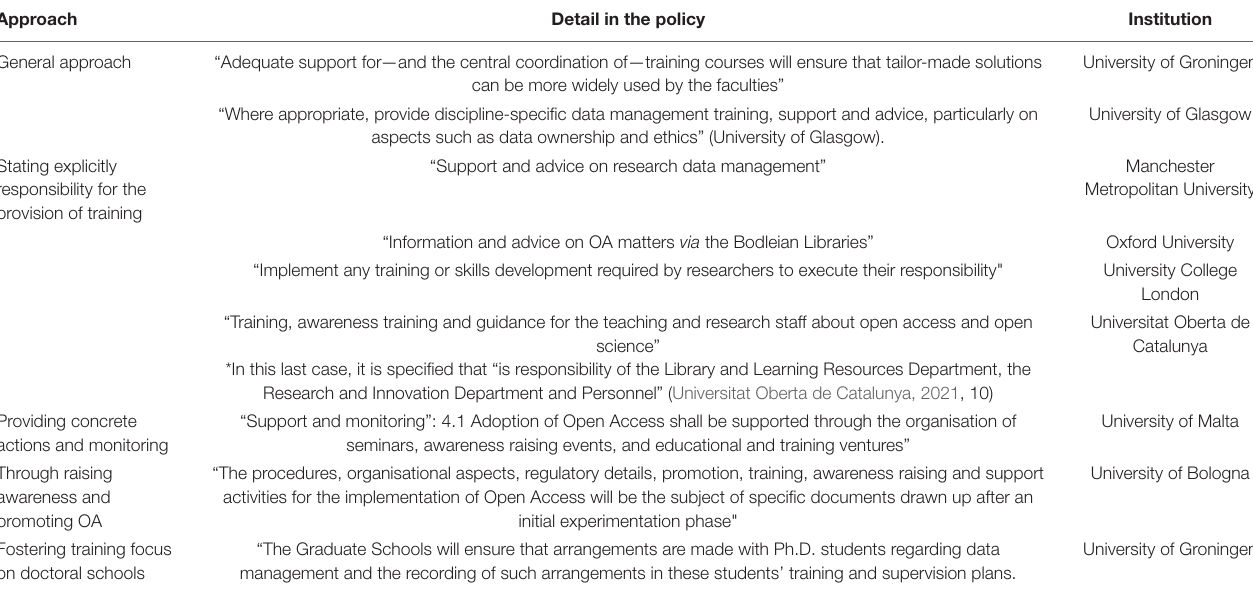
TABLE 5 | Capacity building in institutional